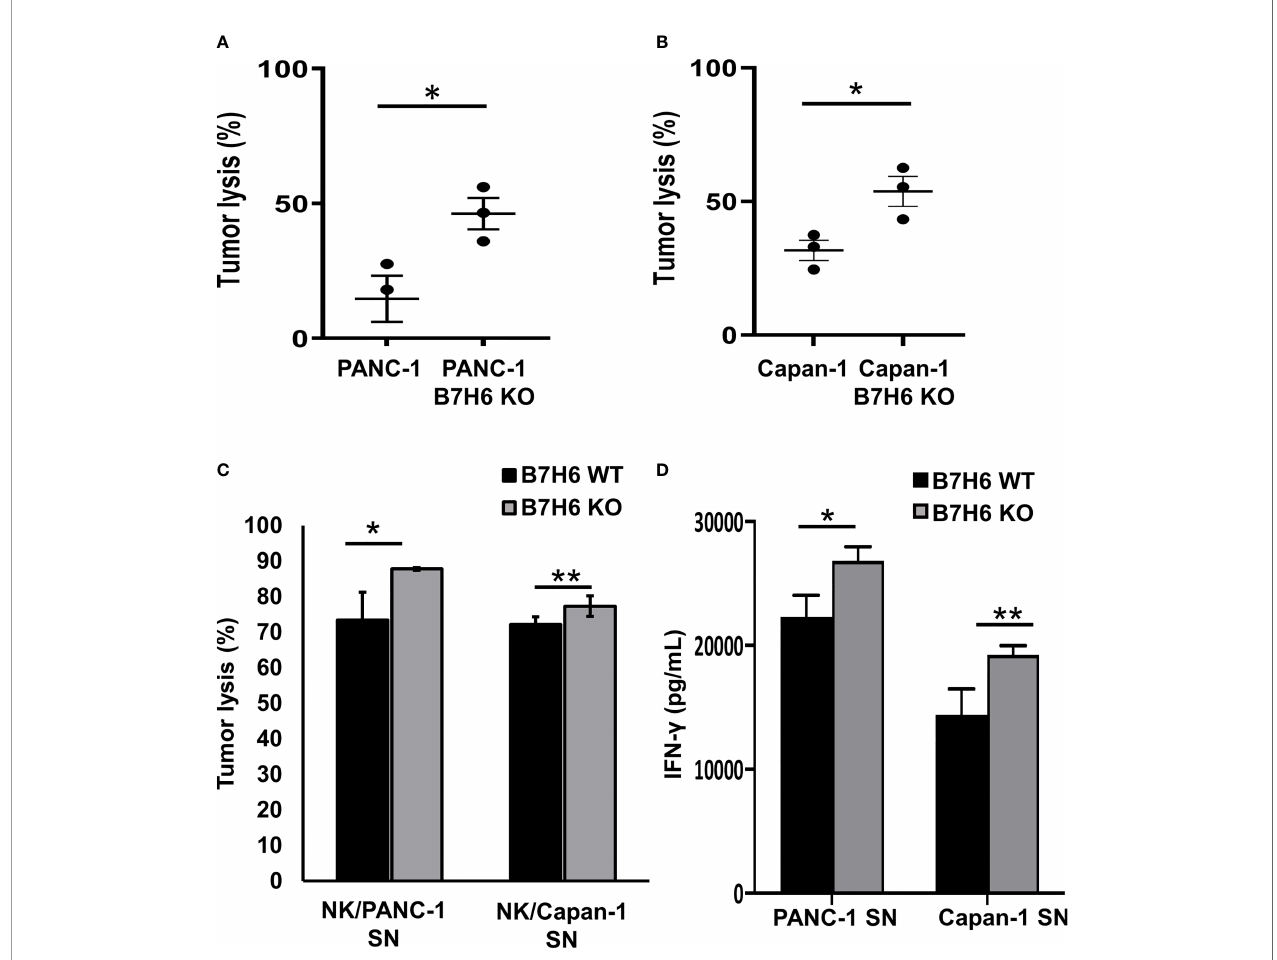
FIGURE 6 | B7H6 mediates NK cytolytic functions. (A, B) Knocking out B7H6 enhanced NK-mediated tumor lysis on PANC-1 cells (A) or Capan-1 cells. (B) Analysis with an ACEA NovoCyte fl ow cytometer. Tumor lysis was calculated by: (cell counts from the tumor-only well − cell counts of the remaining living tumor cells in the sample well)/(cell counts from the tumor only-well − cell counts of the remaining living tumor cells in the well with lysis buffer). Living tumor cells were gated on the singlet, DAPI (-), and ZsGreen-labeled cells. The samples from each well all had the same volume. (C) Conditioned media collected from WT of PANC-1 and Capan-1 cells suppressed the tumor lysing function of NK cells compared to medium from B7H6 KO cells. Lysis was assessed with a standard 4- hour chromium 51 release assay at an E/T ratio of 8:1. (D) IFN- g released by NK cells that had been incubated in supernatant collected from either B7H6 WT or KO PANC-1 or Capan-1 cells. (* P < 0.05, ** P < 0.01). The cytotoxicity assays were repeated with NK cells from 3 donors. Data are shown as mean ±